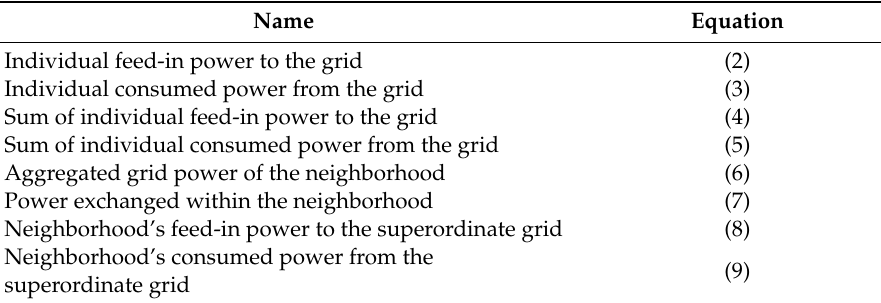
Table 2. Relevant power flows of the neighborhood of PV battery